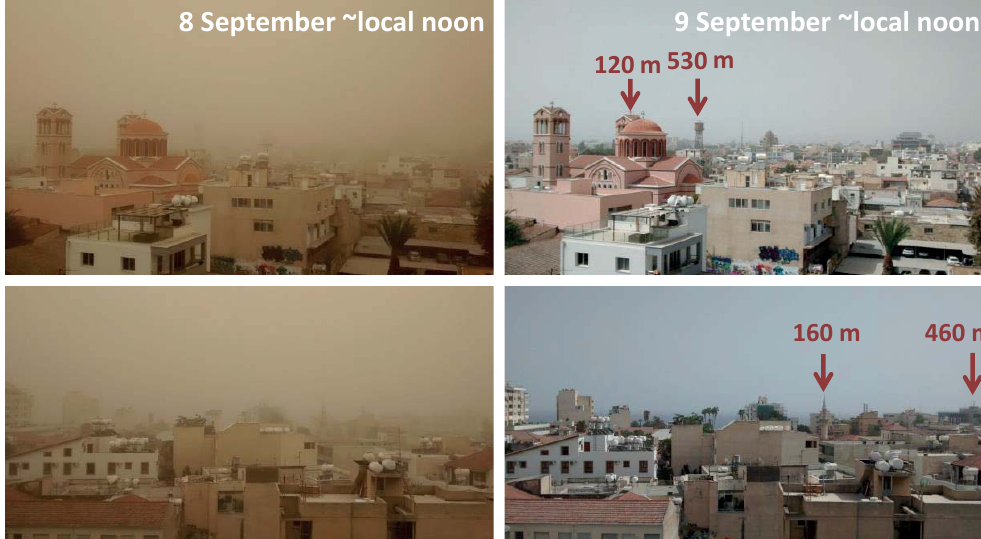
Figure 6. Photographs taken from the roof of a high building (CUT-TEPAK AERONET site) in the city center of Limassol to the north (top) and south (bottom) on 8 September 2015, 08:20–08:30UTC (left) and on 9 September 2015 (right), again around local noon. The meteorological optical range (or horizontal visibility) was about 500m on 8 September and ≥ 10km on 9 September 2015. Distances to several towers from the AERONET station are